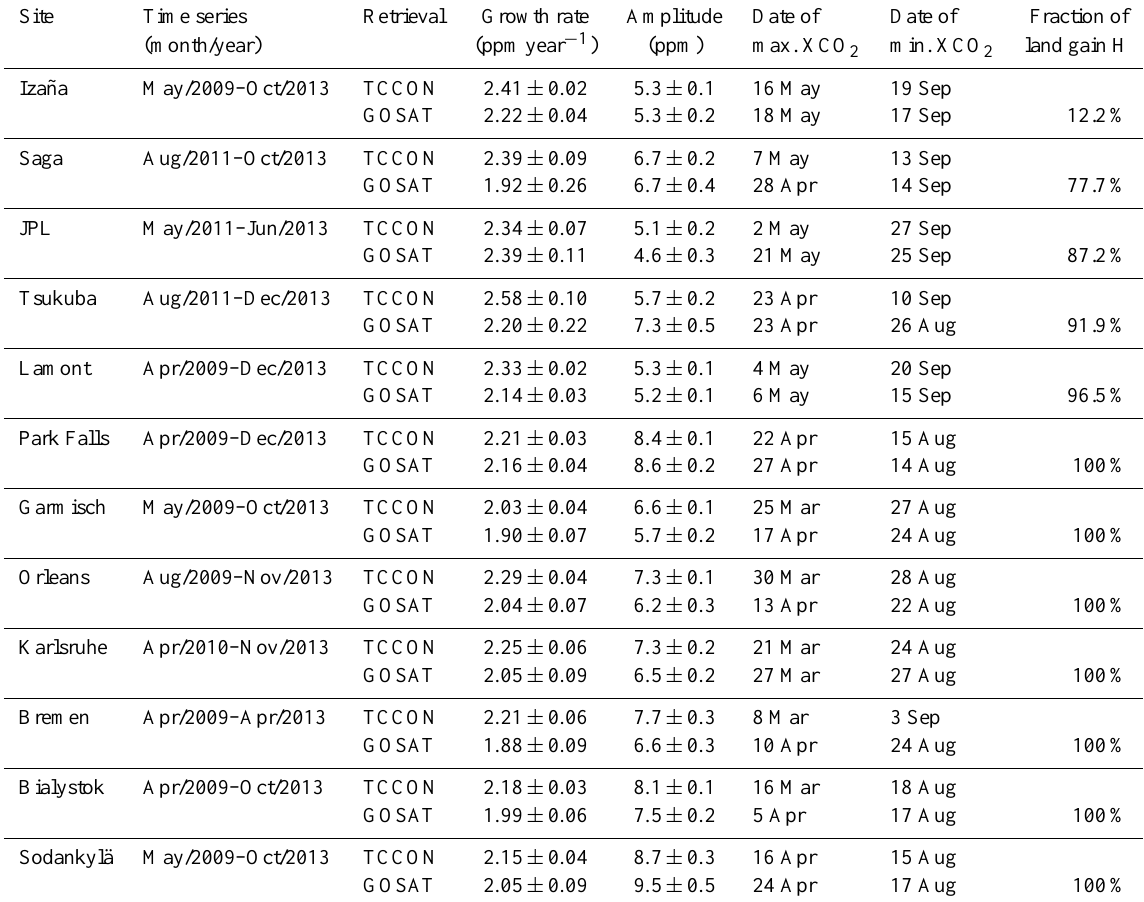
Table 3. Parameters describing the XCO 2 seasonal cycle for TCCON and bias-corrected GOSAT/ACOS B3.5. The fraction of gain H soundings over land is also shown. The validation sites are sorted according to their